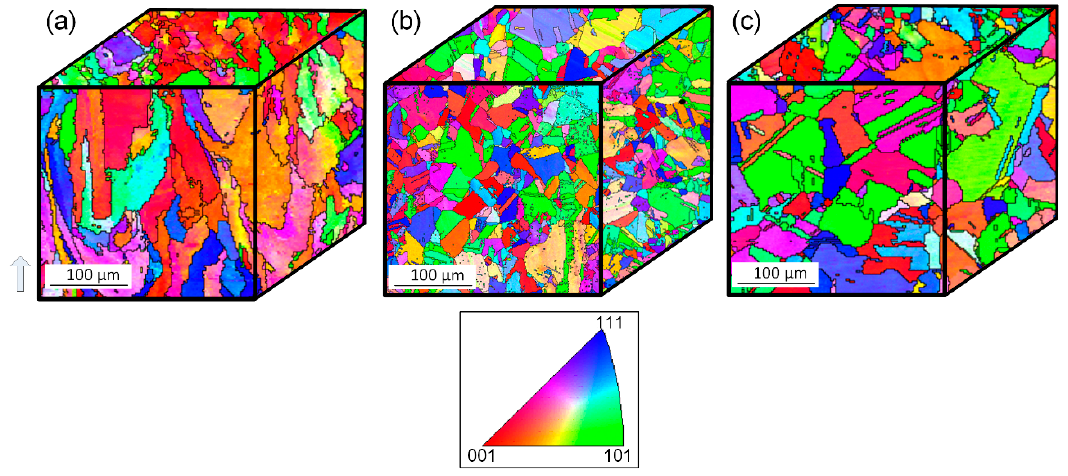
Figure 3. Electron backscatter diffraction (EBSD) images of the ( a ) stress-relief annealing (SR)-, ( b ) solution-treated (ST)-, and ( c ) hot isostatic pressing (HIP)-treated alloys; white arrow shows the build direction. (Color crystal orientation code is inserted.)